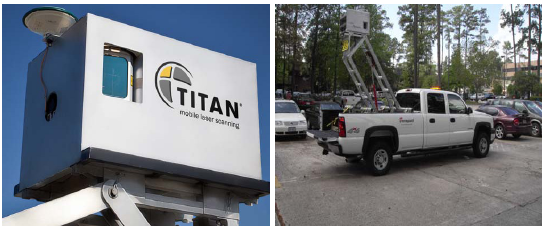
Figure 1. TITAN mobile laser scanning system. Left: Close view. Right: Mounted on a truck. www.ambercore.com